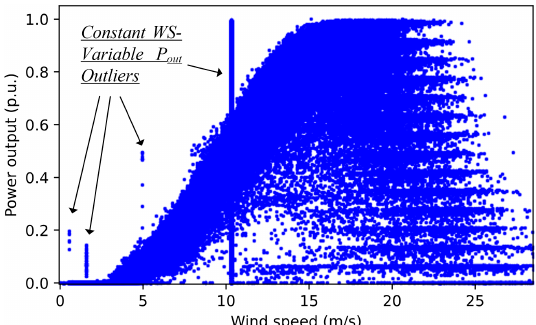
Figure 2. Actual 3-year measurements with indicated different types of outliers for: ( a ) an individual WT. and ( b ) a whole WF (derived from the individual WTs in the same WF).